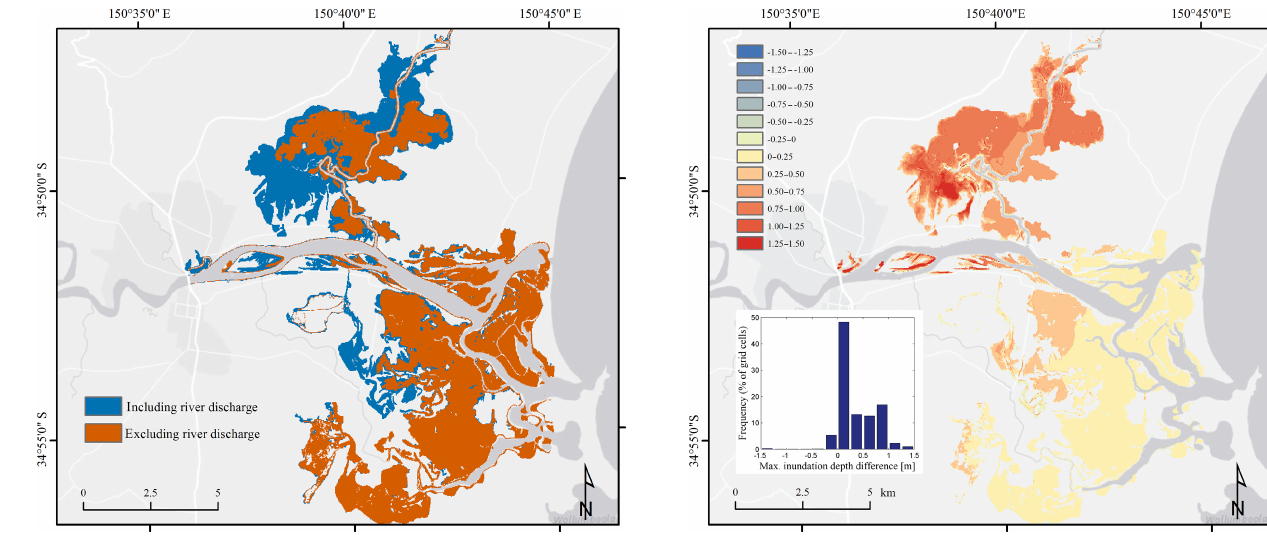
Figure 11. Differences in maximum inundation depth in 0.25m intervals resulting from simulations including and excluding river discharge using the two-open boundary modelling set-up. The his- togram summarises the percentage of grid cells falling into these